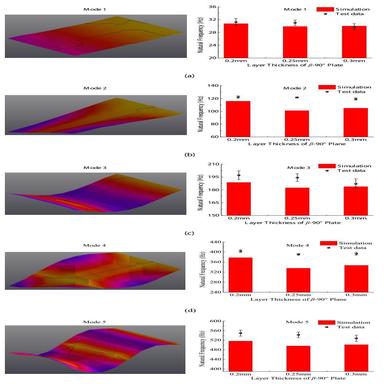
Natural frequency comparison between simulation results and experimental data of FFF 3D printing plates on β plane, (a) mode 1, (b) mode 2, (c) mode 3, (d) mode 4, (e) mode 5.